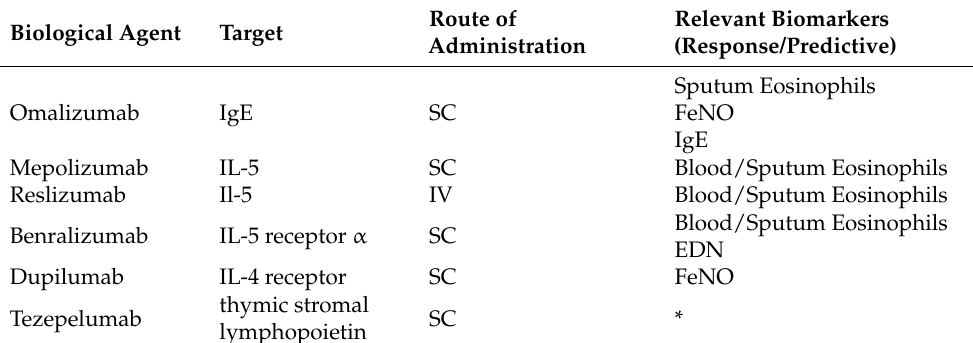
Table 3. Phase III and IV biological agents targeting Th-2 inflammation and relevant suggested biomarkers indicative of a response.